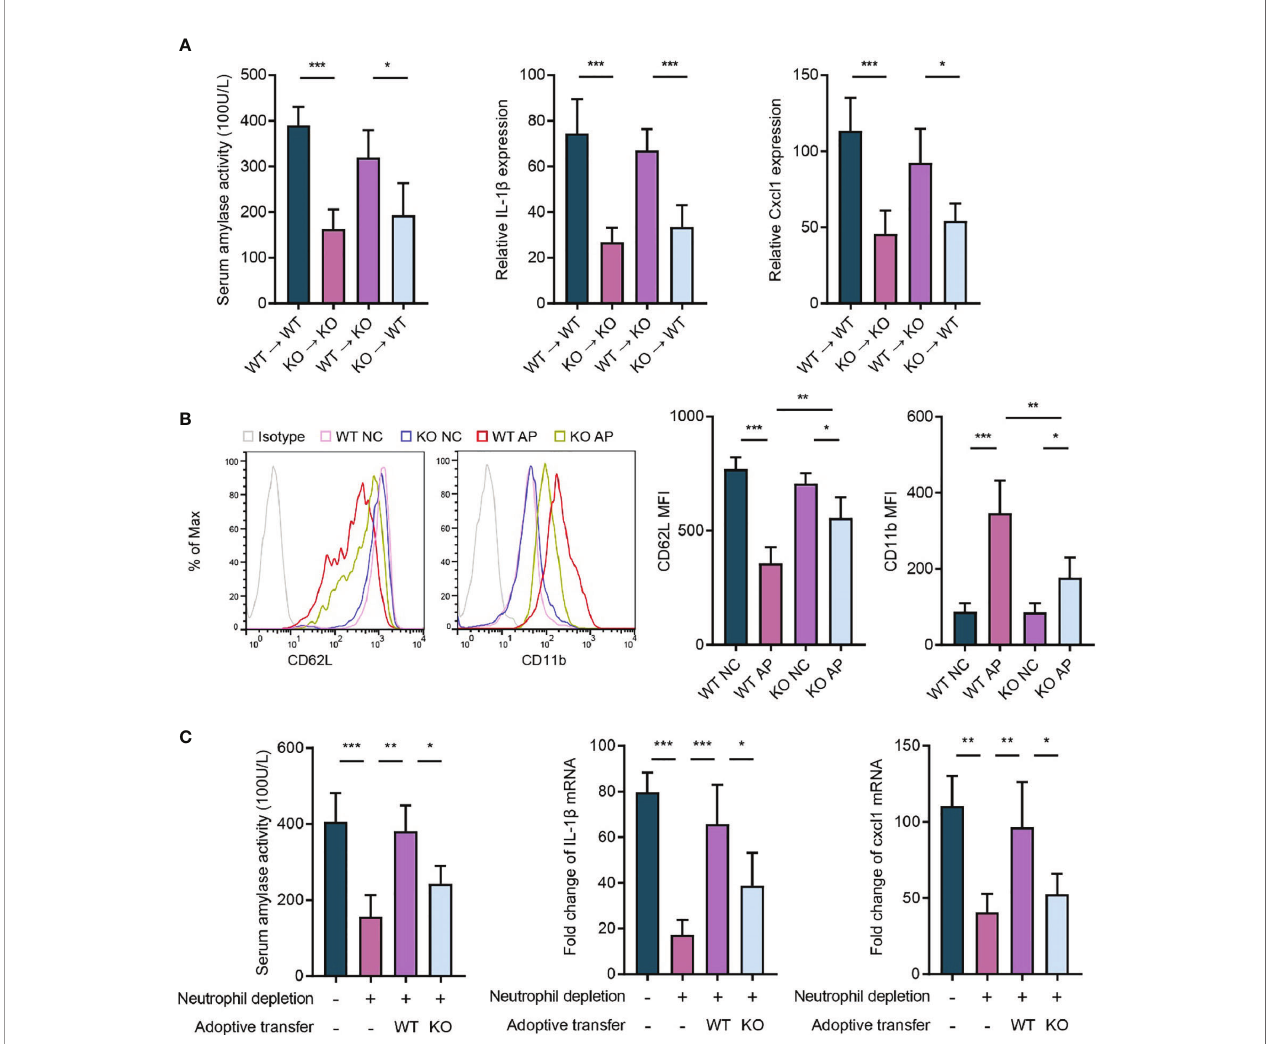
FIGURE 4 | Neutrophil-expressed P2RX1 contributes to the progression of acute pancreatitis. (A) Caerulein (50 m g/kg) was intraperitoneally injected seven times hourly to induce acute pancreatitis in bone marrow chimeras (WT ! WT, KO ! KO, WT ! KO, and KO ! WT). At 8 h after caerulein exposure, serum amylase activity, pancreas IL1- b , and pancreas Cxcl1 expression were analyzed to evaluate in fl ammatory status (n = 4 per group). (B) Caerulein (50 m g/kg) was intraperitoneally injected seven times hourly to induce acute pancreatitis in WT and P2RX1-KO mice. Saline-treated mice were set as negative control (NC). At 8 h after caerulein exposure, fl ow cytometry was performed to detected CD62L and CD11b expression in blood neutrophils (n = 5 each group). (C) Neutrophils in WT mice were depleted by intraperitoneal injection of anti-Ly6G antibody (1A8) 24 h before the fi rst injection of caerulein. Bone marrow neutrophils isolated from of WT or P2RX1-KO mice were intravenously injected 1 h before the fi rst administration of caerulein. At 8 h after caerulein exposure, serum amylase activity, pancreas IL1- b , and pancreas Cxcl1 mRNA expressions were analyzed to evaluate in fl ammatory status (n = 4 per group). 2 − dd Ct value was used for comparisons of the fold change of mRNA expression to NC mice. Statistics were calculated using one-way ANOVA with Tukey post-tests (A, C) , or Student ’ s t test (B) . * P < 0.05, ** P < 0.01, *** P <